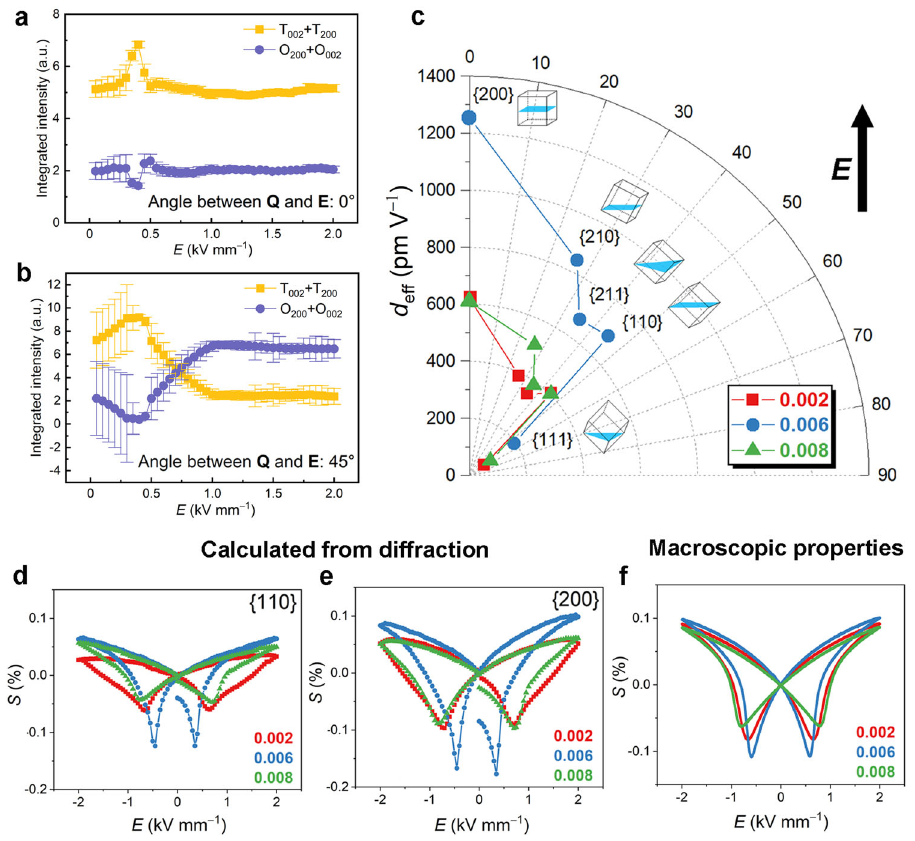
Fig. 3 Crystallographic analysis of the phase transition and electric fi eld-induced strains. a , b Summed integrated intensity of the 002 and 200 re fl ections of the tetragonal phase and the orthorhombic phase. Results were obtained in the a 0°-sector and b 45°-sector at an applied electric fi eld of 0 to 2 kV mm − 1 . c Orientation-dependent piezoelectric coef fi cient d eff of compositions x = 0.002, 0.006, and 0.008. Strain-electric fi eld ( S - E ) hysteresis loops calculated from the evolution of the centers of mass of d 110 and e 200 re fl ections with the electric fi eld. f Experimentally measured macroscopic S – E hysteresis